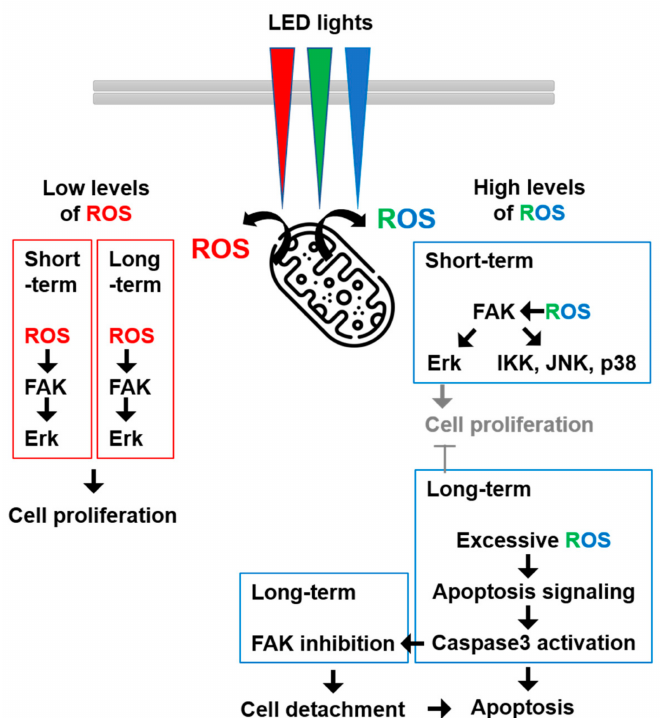
Figure 7. LED light exposure modulated FAK-related signaling events differently via ROS in HaCaT cells. Red LED light induced mitogenic effects via a low-level ROS-FAK-ERK axis, while green and blue LED lights induced cytotoxic effects via apoptosis signaling by generating high levels of